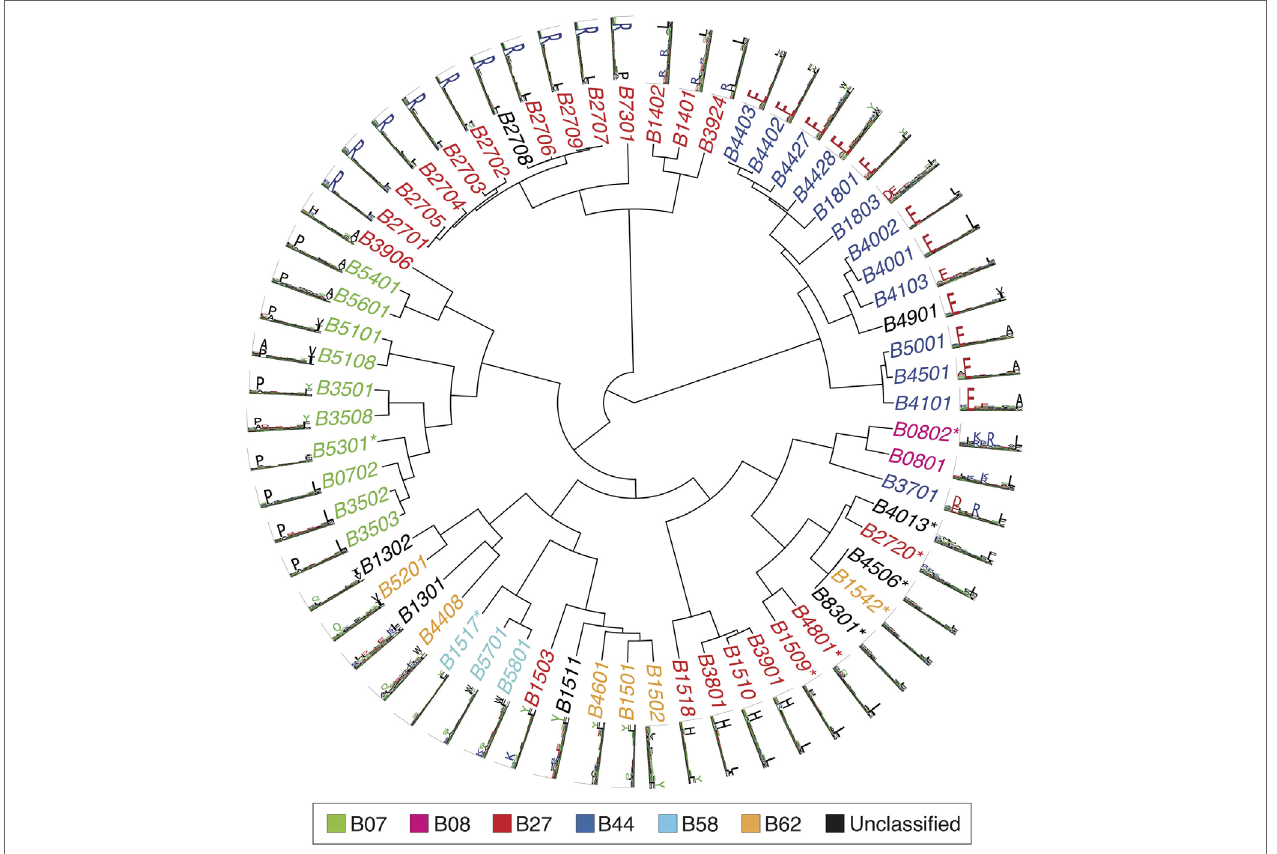
FiGURe 3 | Hierarchical clustering of HLA-B alleles based on their binding specificity. Stars indicate cases where only in vitro binding data were available to generate the motifs. In all other cases, only mass spectrometry data were used. Name colors and their description in the legend indicate supertypes as defined in Ref.